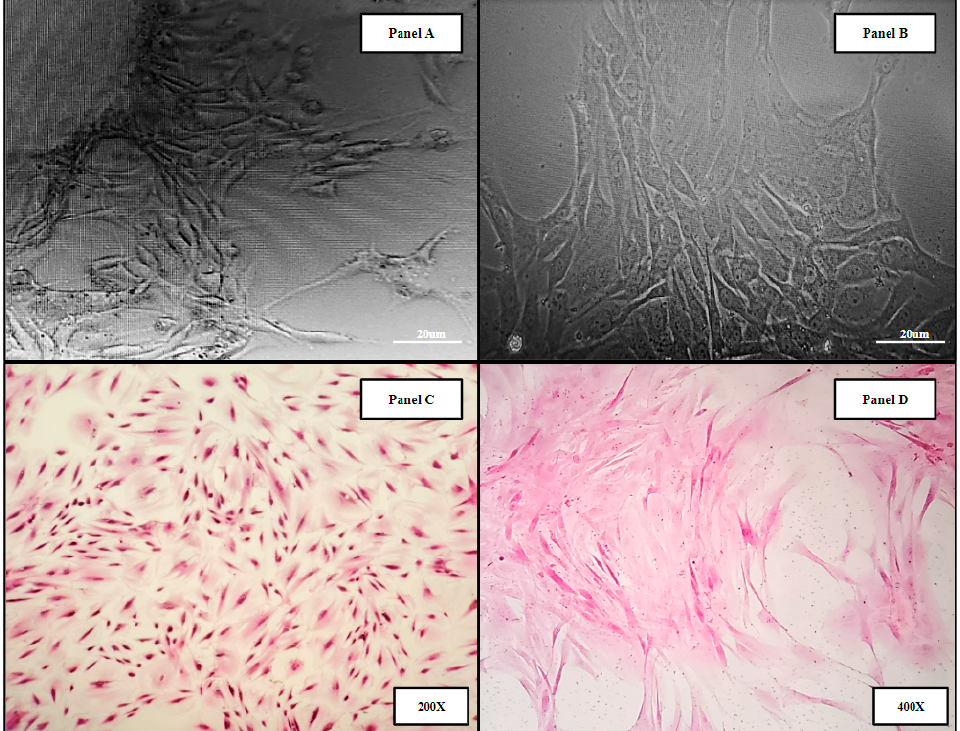
Figure 2. Representative images of primary hBM cell populations isolated from whole bone marrow aspirate and material from long bone fracture reaming. The derived cell populations are composed of native bone marrow progenitor cell subtypes including mesenchymal stromal cells and hematopoietic stem cells. Panels ( A , B ) display primary hBM cells in culture taken at days 5 and 15, respectively, as the populations were expanded. Panels ( C , D ) display monolayer H&E-stained slides of the hBM cell population.